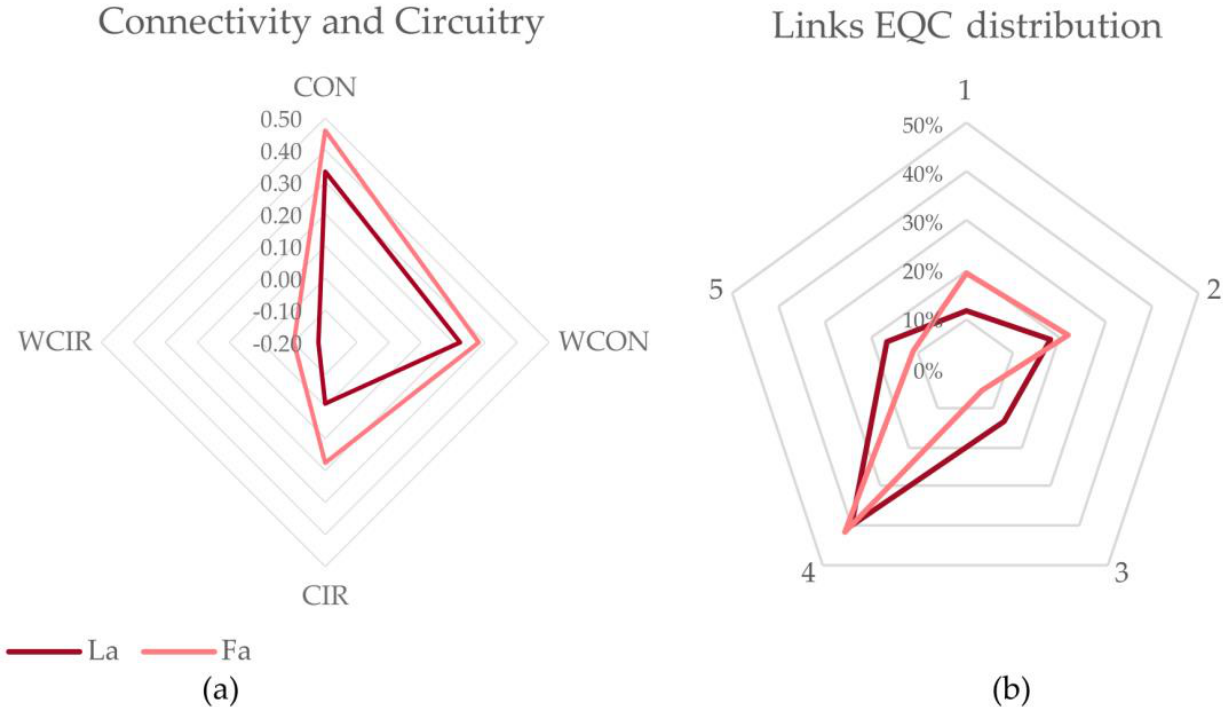
Figure 6. ( a ) Comparison of results on connectivity (CON: connectivity and WCON: weighted connectivity) and circuitry (CIR: circuitry and WCIR: weighted circuitry) indices for local ( La ) and farm ( Fa ) scales; and ( b ) comparison of the distribution of La and Fa scale links among the five EQC y . In line with these results, the landscape apparatus analysis revealed low connectivity functions throughout the overall La context. Their spread across the agricultural